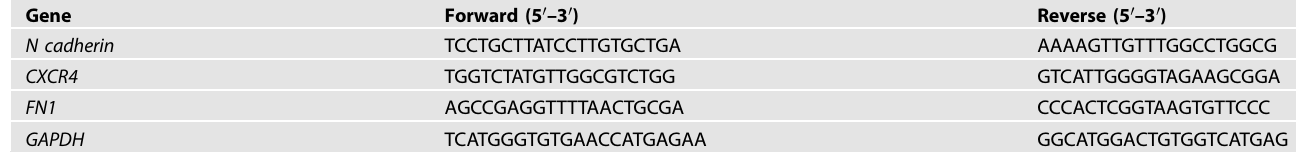
Table 1. Sequences of the